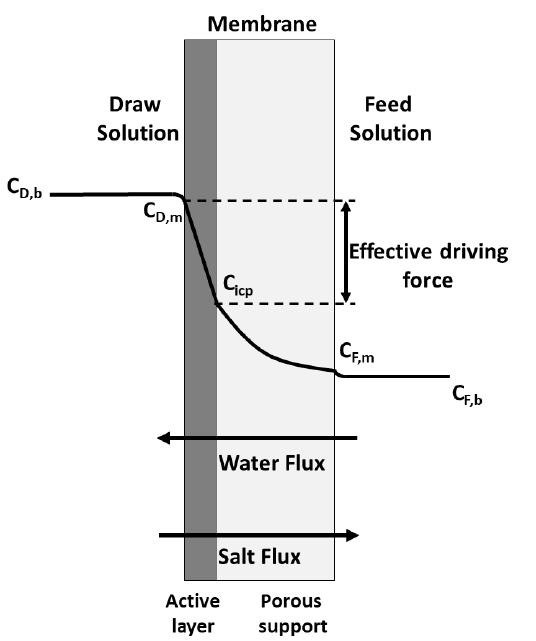
Figure 3. PRO concentration profile for an asymmetric membrane with the active dense layer facing the draw solution.